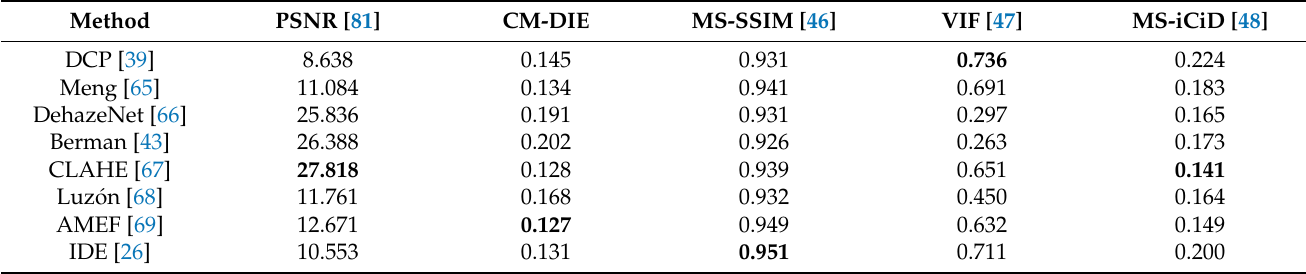
Table 3. Quantitative results of sRGB rendering image quality metrics for the different dehazing methods. The best method is marked in